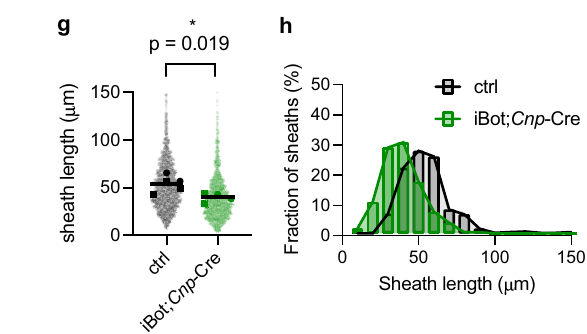
Fig. 4 | VAMP2/3-mediated membraneexpansion is requiredfor myelin sheath elongation. a Schematic of co-cultures between oligodendrocytes (magenta) and CNS-derived axons from retinal ganglion cell aggregates with radially protruding axons (gray). Created with BioRender.com. b Primary oligodendrocytes puri fi ed fromcontrol(top)oriBot; Cnp -Cremousebrains(bottom)culturedonCNS-derived axons(retinalganglioncellre-aggregates)for7daysandstainedforMBP(magenta) and NF200 (white), with GFP to mark iBot expression (green). All scale bars, 200 μ m. See Supplementary Fig. 8 for examples of sheath quanti fi cation. Source data are provided in the Source Data fi le. Quanti fi cation of the number of sheaths peroligodendrocyte( c )andthelengthofsheaths( d )fromco-cultures,whereeach light-shaded point represents a single sheath, each dark-shaded point represents themeanlengthofallsheathsfromonebiologicallyindependentreplicate,andthe line represents the mean sheath length from n =4 biologically independent repli- cates with 33 – 63 cells each. Mean number of sheaths per cell body±SEM: control 9.8±1.8, iBot 6.9±1.2. Mean sheath length±SEM: control 90.9±5.2 μ m, iBot